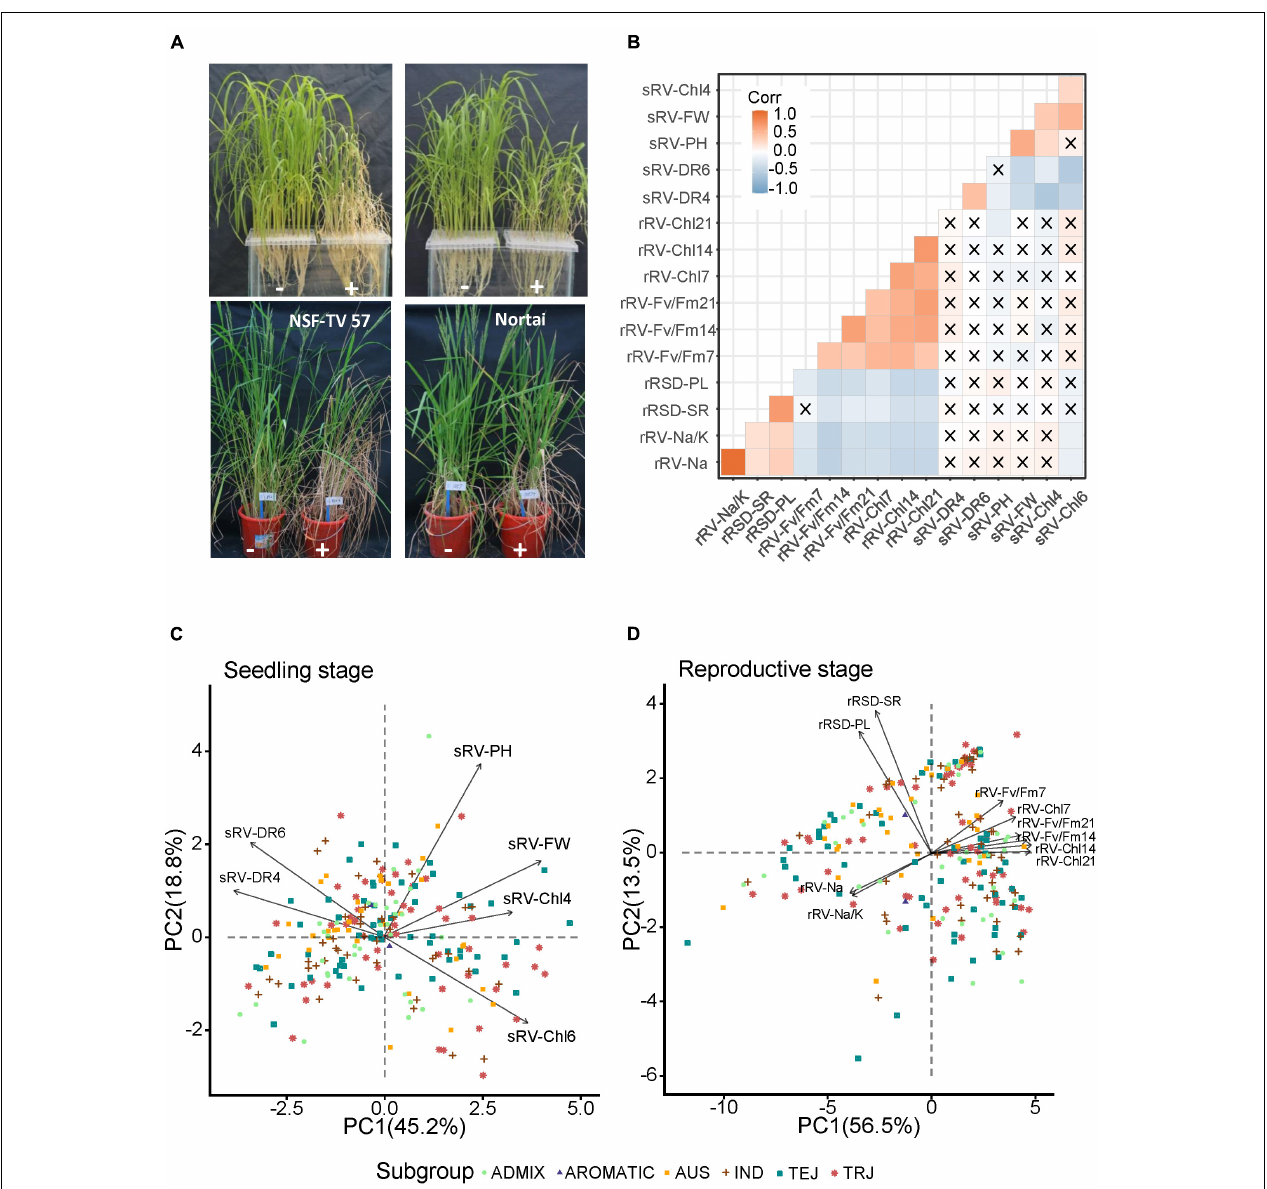
FIGURE 1 | Phenotype and principal component analysis (PCA) of indices under salt stress at seedling and reproductive stages. (A) Comparison of rice accessions with (+) and without (–) NaCl treatment. Pictures for seedling stages were taken at 4 days after treated with and without 0.8% NaCl. Pictures for reproductive stages were taken at 14 days after treated with and without 0.5% NaCl. Left and right pictures in each panel refer to different rice accessions with different tolerance to salt stress at seedling or reproductive stages, respectively. (B) Pearson correlation coefficient matrix of 16 ST indices. The cross indicates that the correlations did not reach statistically significant level at p < 0.05. Red and blue refer to positive and negative correlation, respectively. (C,D) PCA analysis of salt tolerance (ST) indices at seedling and reproductive stages, respectively. Total of 220 accessions were plotted on PCA plot with different shapes and colors. Each arrow represents an index and the length refers to its contribution on ST. The angles captained by any of the two arrows less than 90 ◦ imply the two indices having positive correlation, otherwise represent negative correlation between the two